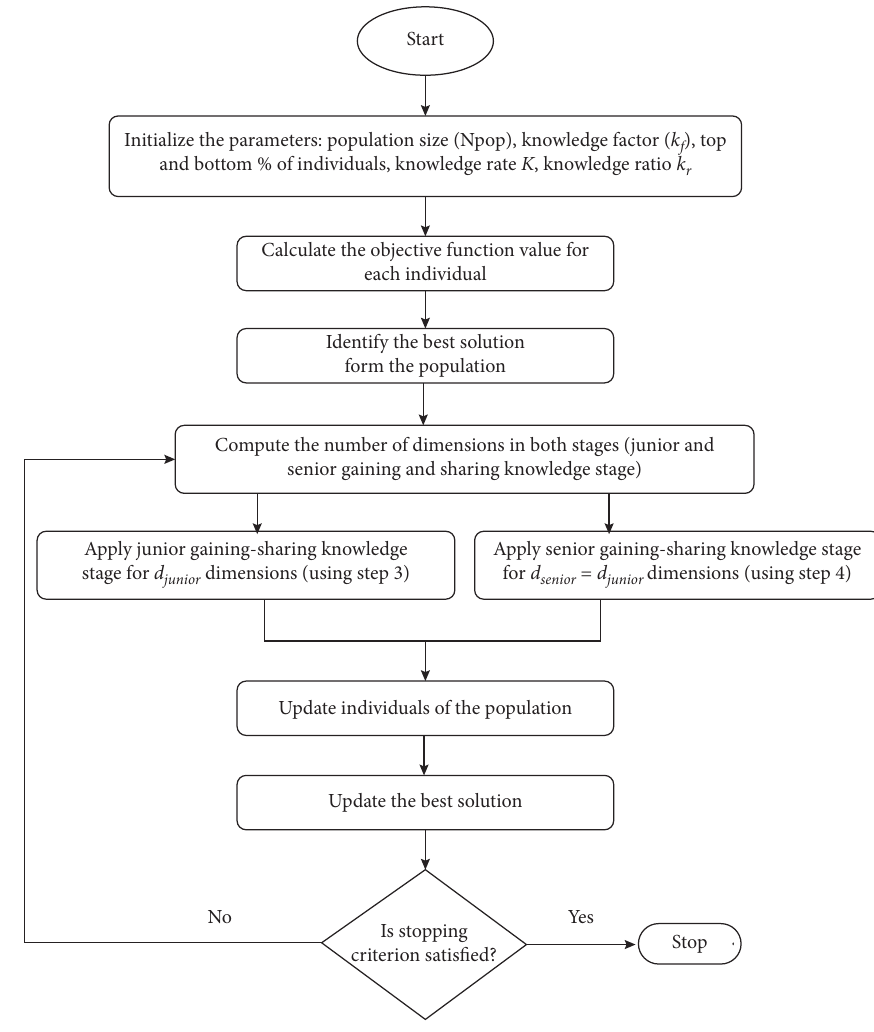
Figure 5: The flowchart of IGSK.